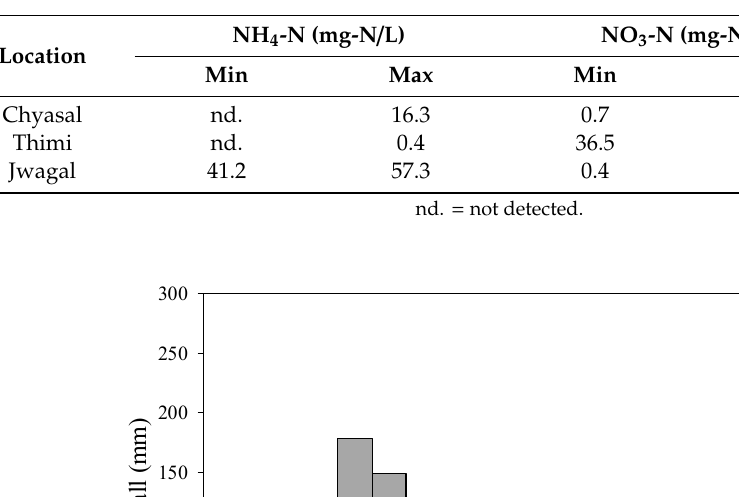
Table 2. Statistical variations of the monthly samples collected from shallow groundwater (Chyasal and Thimi) and deep groundwater (Jwagal).